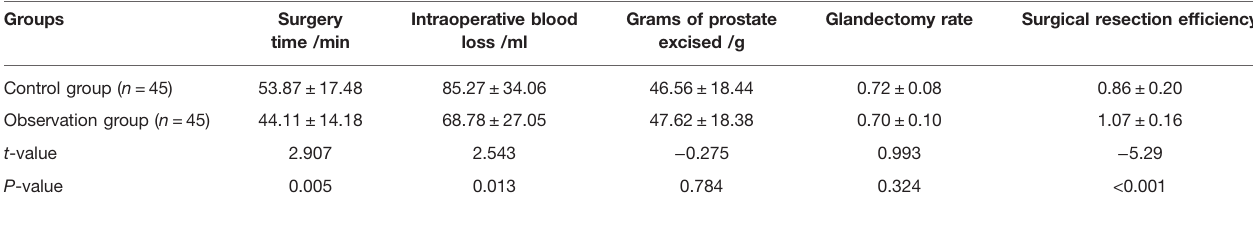
TABLE 2 | Surgical